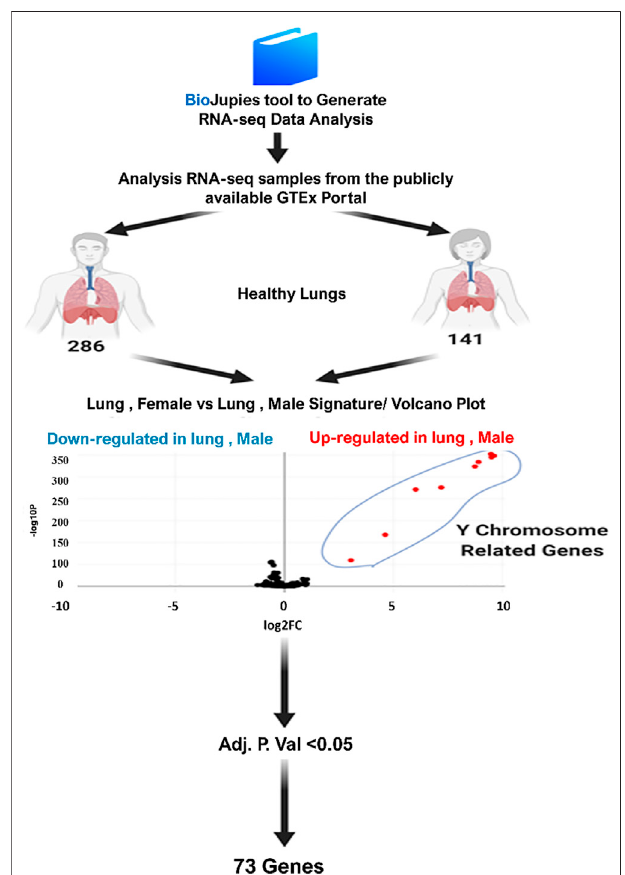
FIGURE 1 | Schematic representation to bioinformatics analysis of differentially expressed genes in males compared to females ’ lung tissues using BioJupies tools (Caramelo et al.,